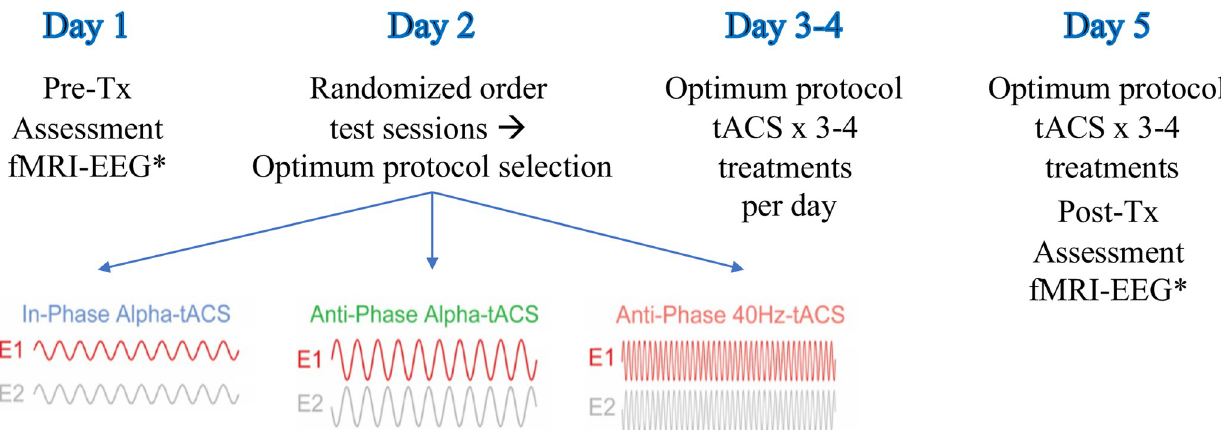
Fig 2. Study procedures Day 1 through Day 5. Baseline clinical and symptom assessments were performed in the morning with fMRI and EEG obtained in the afternoon of Day 1. Day 2 entailed test sessions of each of three protocols (anti-phase, in-phase, control) given in an unlabeled and randomized order. Participants elected their individually most effective protocol. Individually chosen optimal treatments were given on the mornings of Days 3 and 4. Final treatments were given on the morning of Day 5 followed by fMRI and EEG in the afternoon.